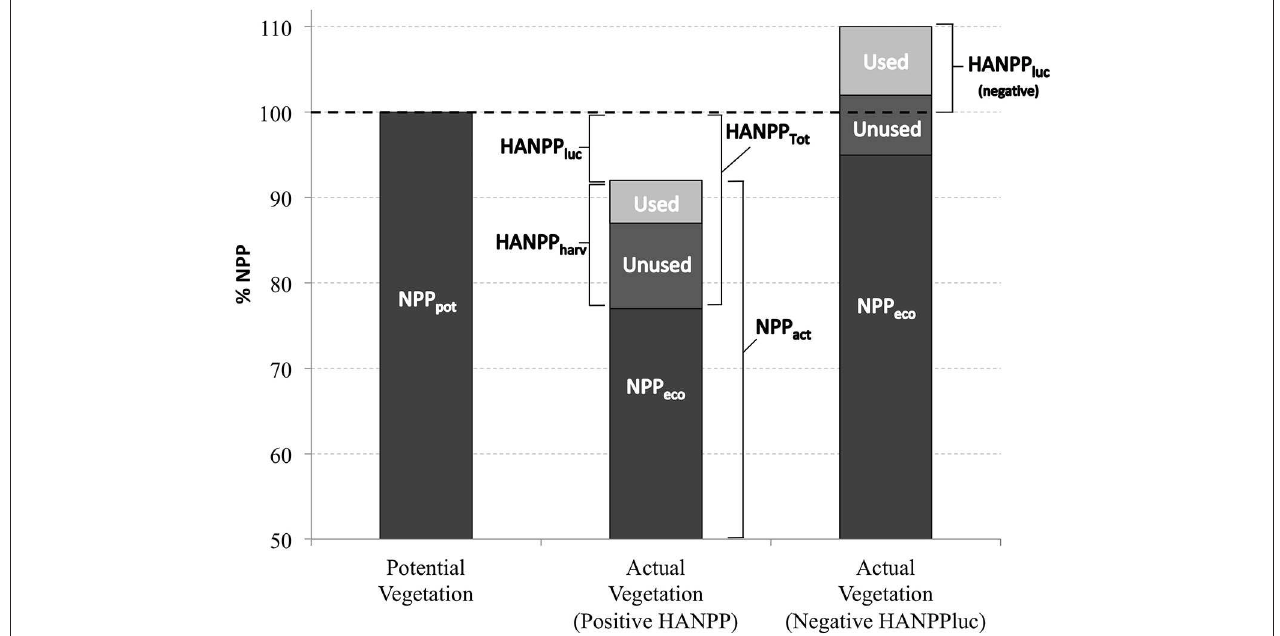
FIGURE 1 | How to measure the HANPP of a landscape. HANPP is a combination of HANPPharv [the NPP harvested, whether it is used (removed from the landscape) or unused (left in the landscape)] and HANPPluc (the change in NPP induced by conversion of the native ecosystem to the current land). The actual NPP of the converted landscape includes both the NPPeco (NPP of the current ecosystem) and HANPPharv. If the combination of HANPPharv and NPPeco are lower than NPPpot, HANPPluc is postive and added to generate HANPPTot. However, if the combination of NPPeco and HANPPharv is higher than NPPpot, HANPPluc is then subtracted to determine